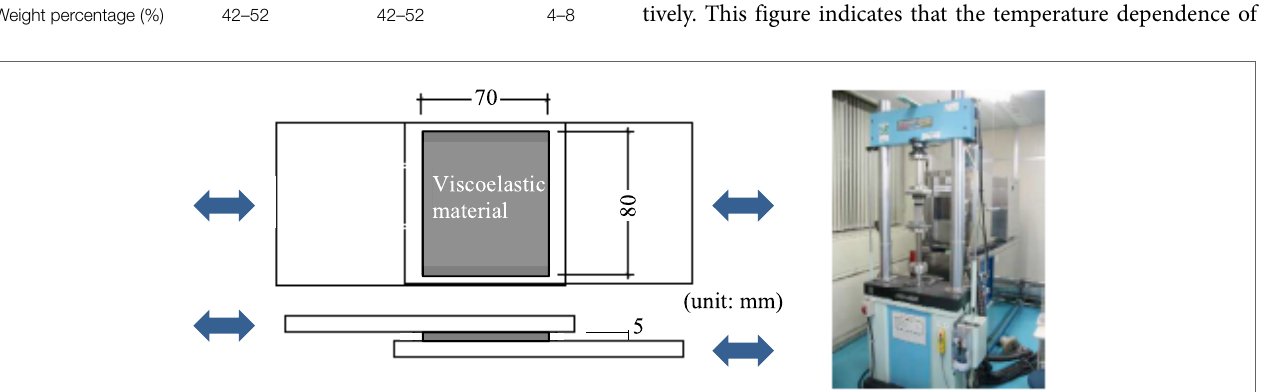
FIGURE 3 | Test specimen of VE material and the dynamic testing machine .